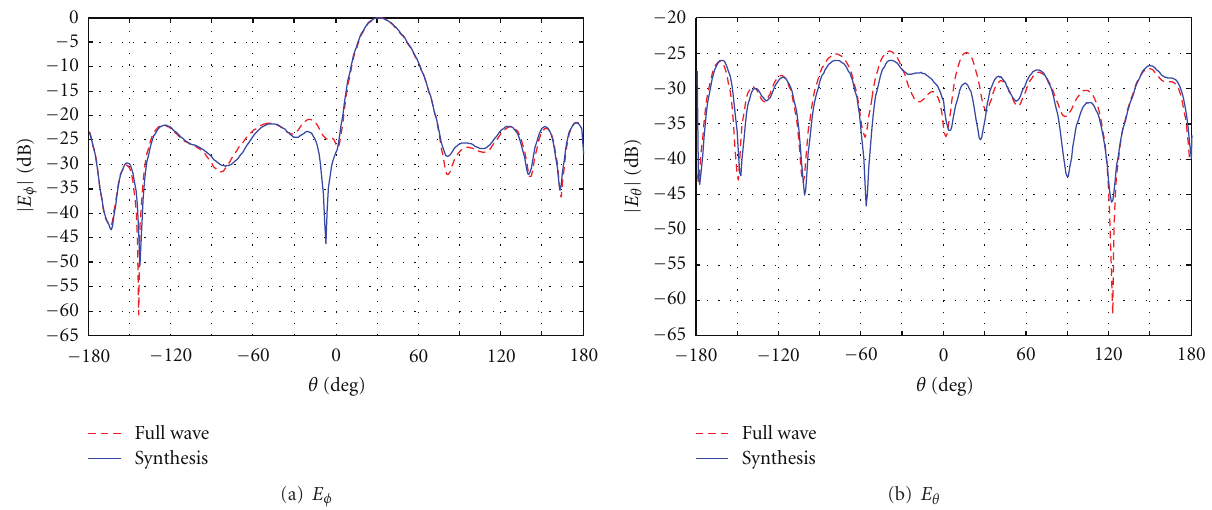
Figure 5: A comparison between the realized pattern using the proposed hybrid method and the simulated by CST in the planes ϕ = 90 and ϕ =